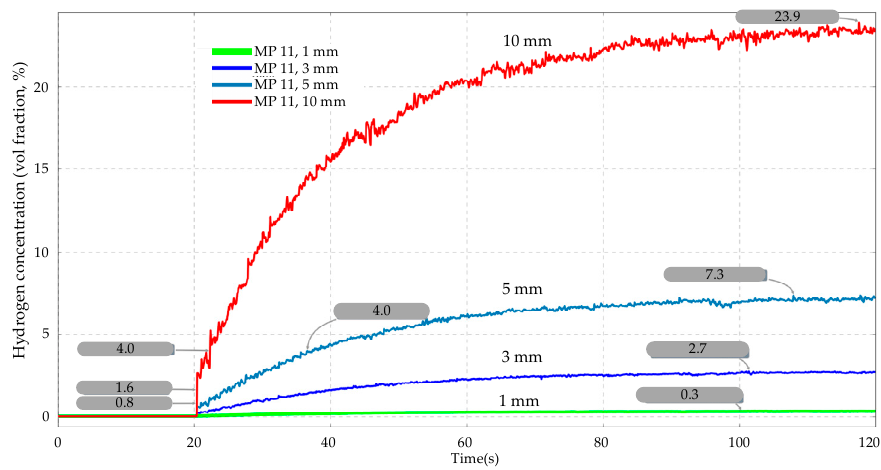
Figure 11. Hydrogen concentration at MP11 for different leak diameters.